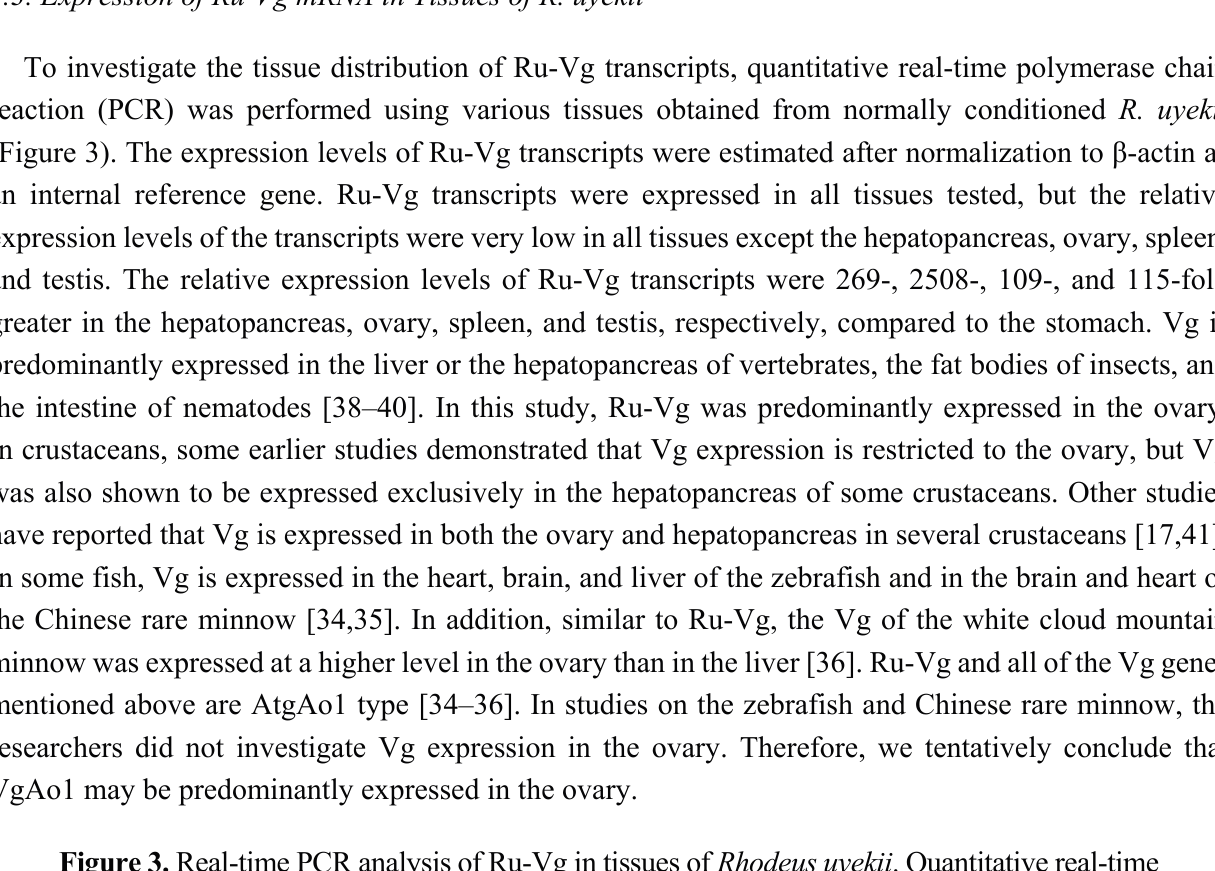
Figure 3. Real-time PCR analysis of Ru-Vg in tissues of Rhodeus uyekii . Quantitative